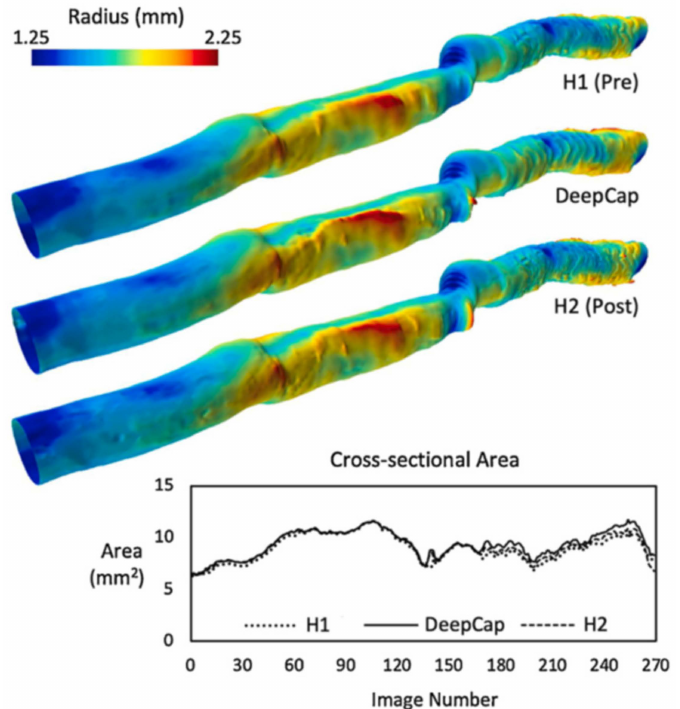
Figure 5. A comparison between the proposed DeepCap model and two manually annotated reconstructions (H1 and H2). The proposed model agrees well with both manual reconstructions, with the 3D lumen surface visualizing the radius measured from the lumen centroids and the graph showing the cross-sectional area along the length of the vessel. The automated DeepCap segmentation was able to process the 200-image pullback in just 0.8 s on a GPU (19 s on CPU). Reprinted from [93], with permission from